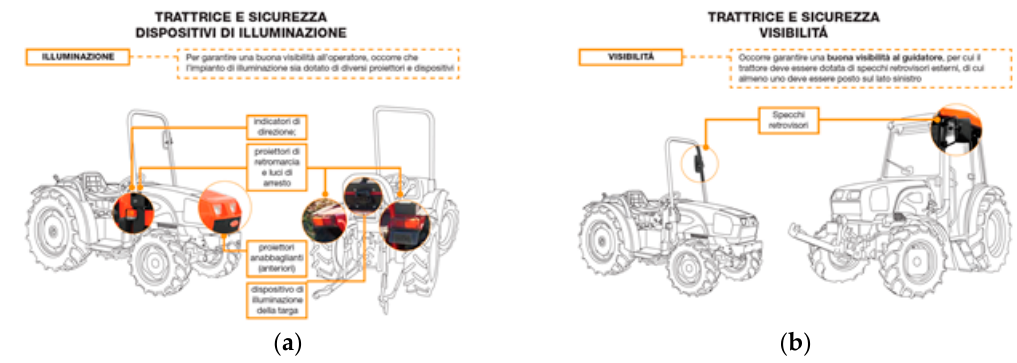
Figure 4. Images developed to focus users’ attention on specific details on the tractor: ( a ) what and where the lighting devices are and ( b ) where the vision devices such as the rear-view mirrors are.